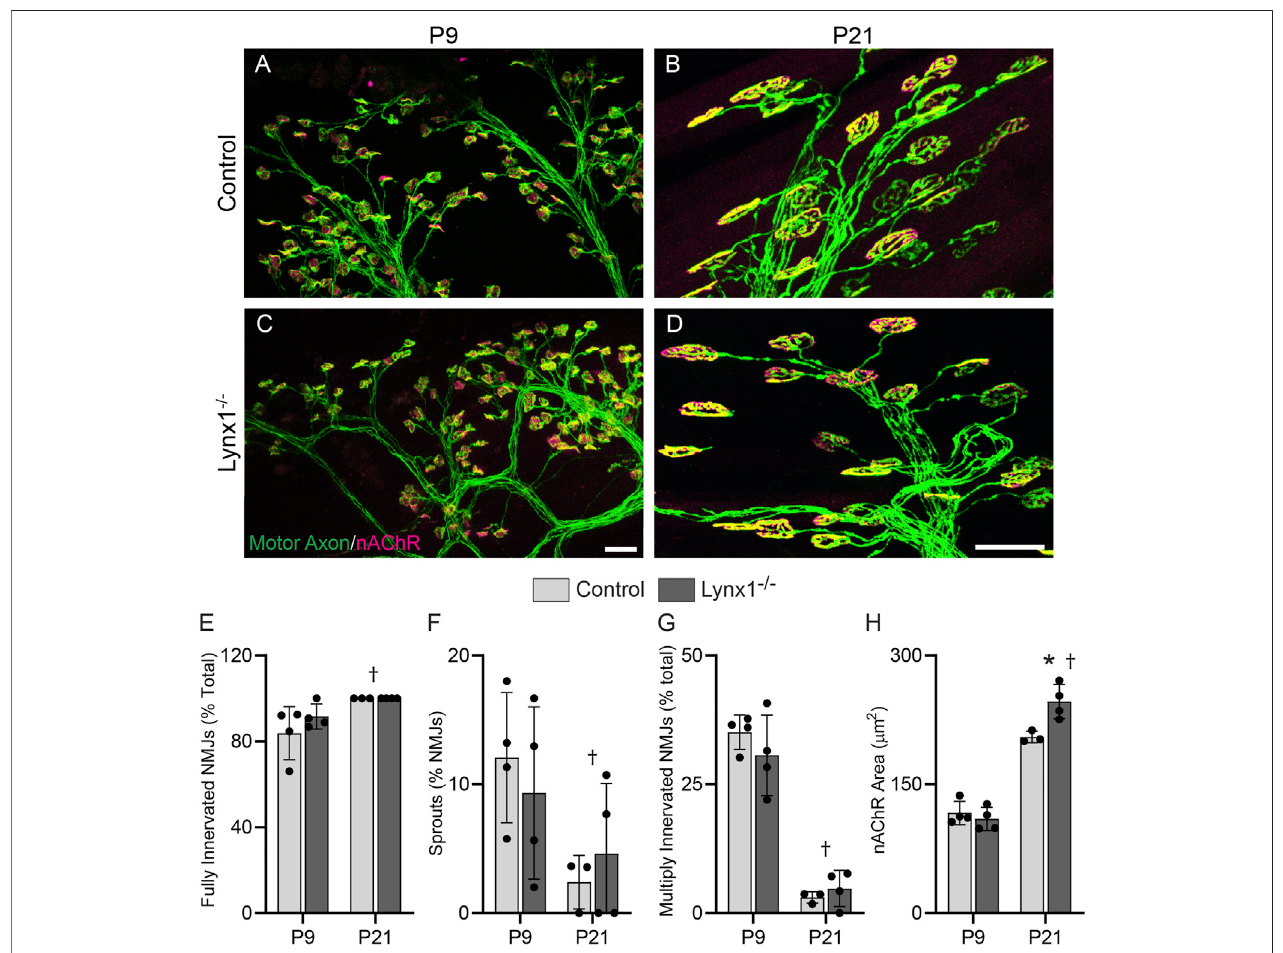
FIGURE5| LossofLynx1hasnodiscernableimpactonNMJdevelopment. (A – D) RepresentativeimagesofNMJsintheextensordigitorumlongus(EDL)muscles of P9 (A,C) and P21 (B,D) control and Lynx1 − / − mice. Motor axons were labeled with YFP (green) and nicotinic acetylcholine receptors (nAChRs) were labeled with fl uorescentlyconjugated α -bungarotoxin(fBTX,magenta). (E – H) Morphologicalanalysisofneuromuscularjunctions(NMJs),including (E) thedegreeofNMJinnervation, (F) the percentage of NMJs with axonal sprouts, (G) the percentage of NMJs innervated by more than one axon, and (H) NMJ area, as determined by the area of nAChR clusters. All values are mean ± SD. † Age effect, p < 0.05, two-way ANOVA. * p < 0.05 versus age-matched control, two-way ANOVA with Š ídák ’ s multiple comparisons test. n ≥ 3. Scale bar = 20 µm.